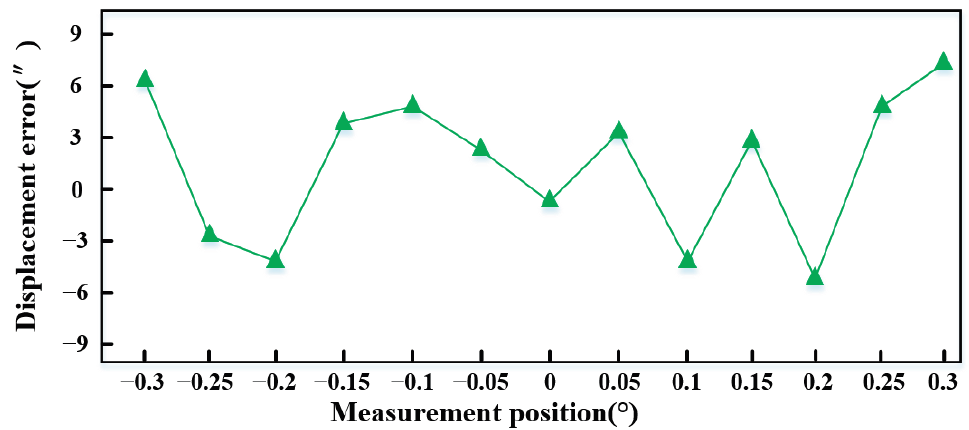
Figure 19. Measurement error of θ Z